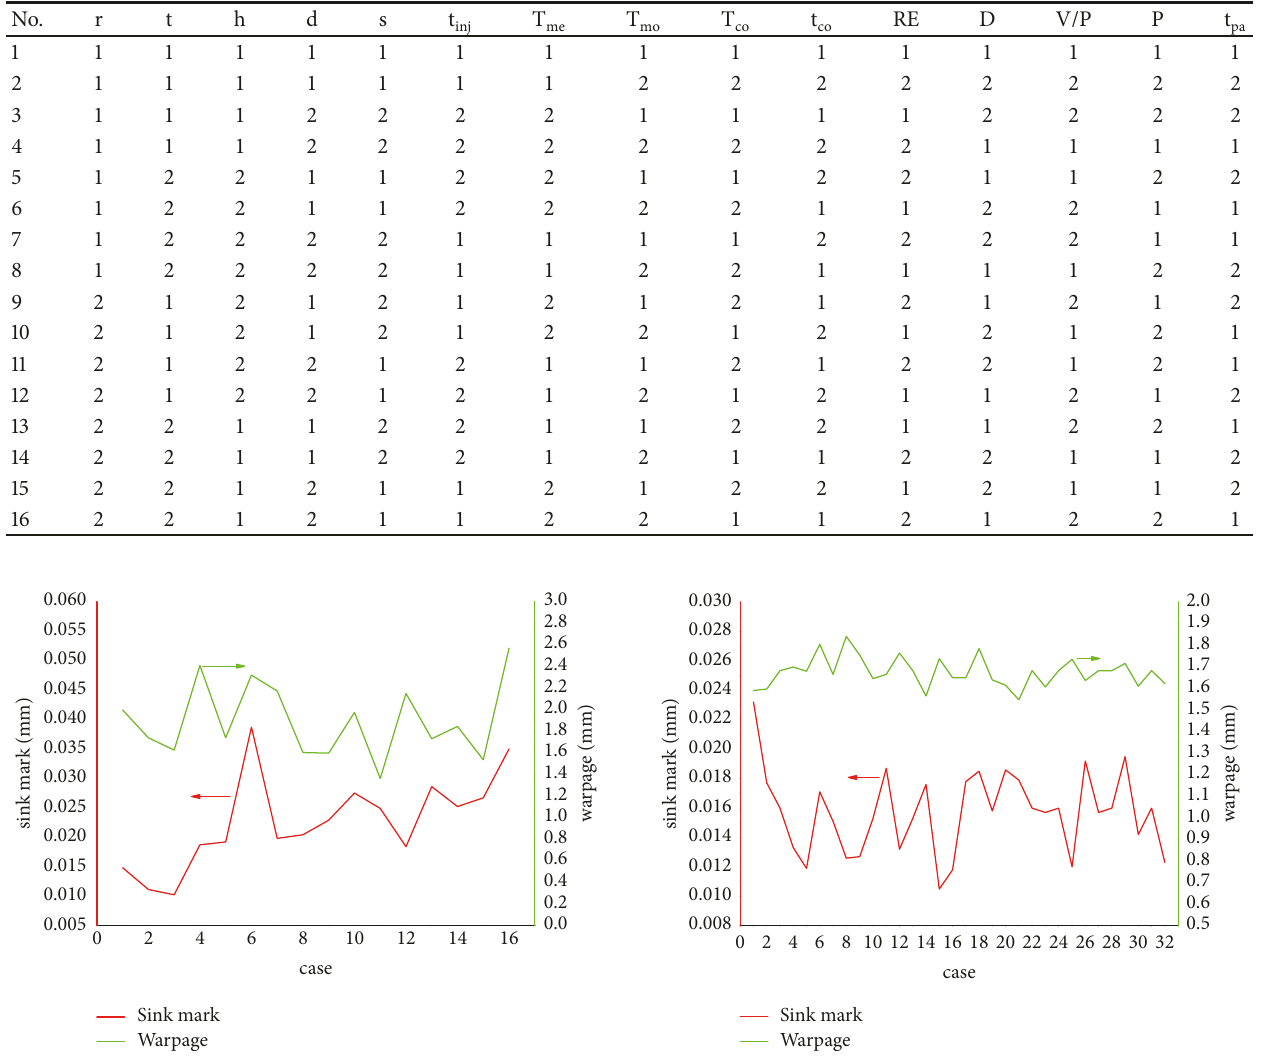
Figure 8: Results of sink marks and warpage. Figure 9: Results of sink marks and warpage.